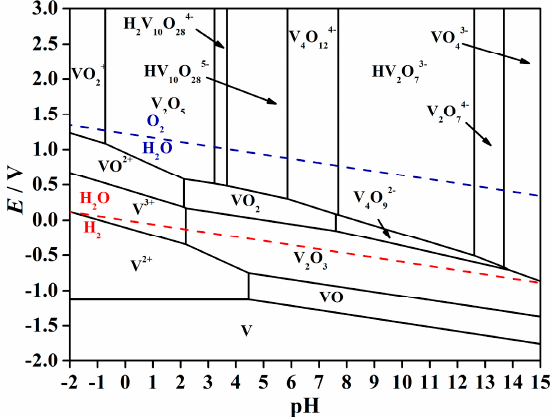
Figure 5. Potential–pH diagram for V–H 2 O system at 298 K with activities of dissolved vanadium of 1 mol/L and H 2 partial pressure of 1 atm.